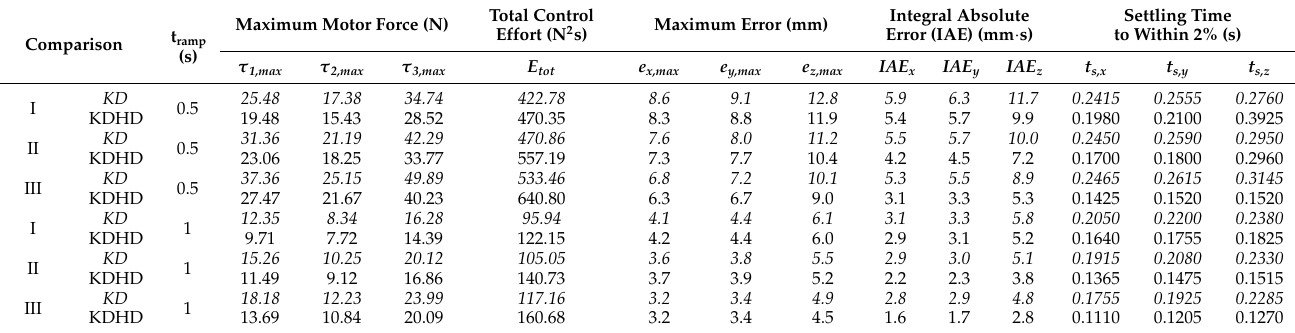
Table 3. KD/KDHD impedance control comparison, case study